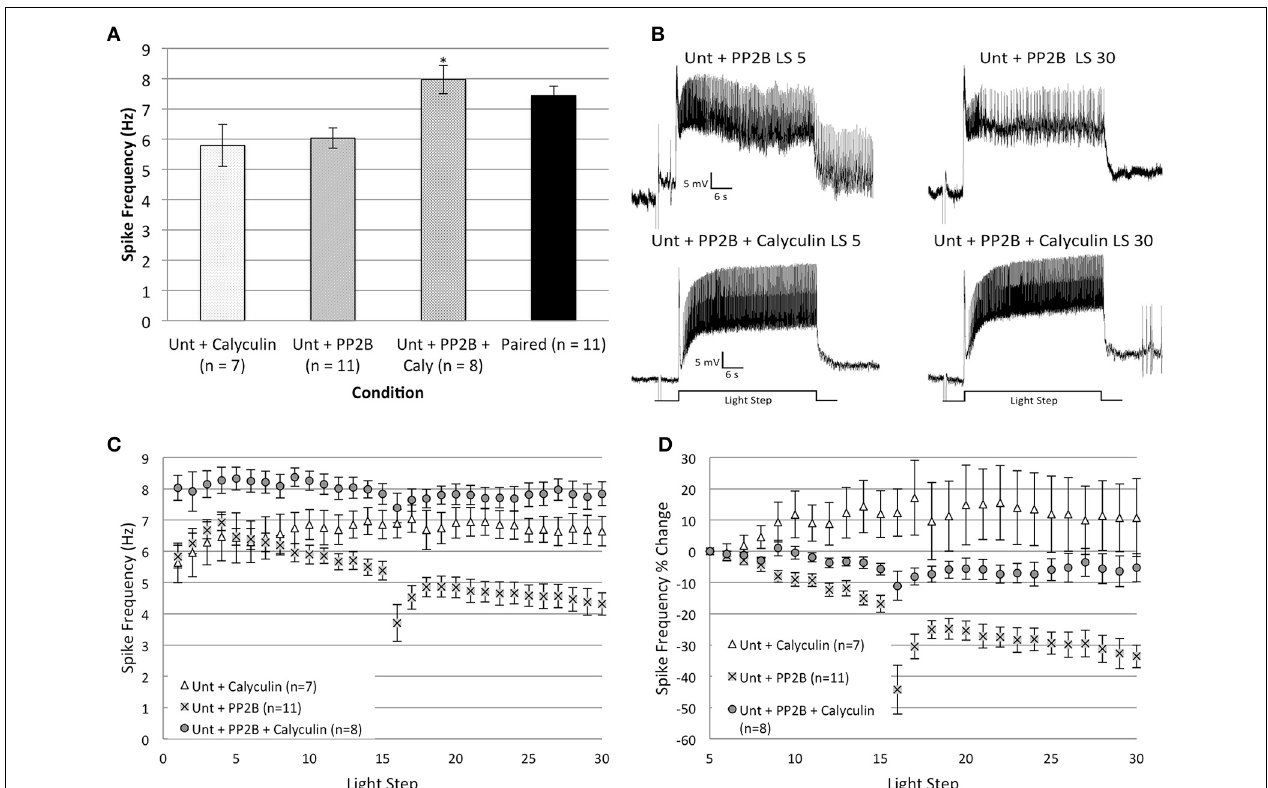
FIGURE 8 | The incubation of Untrained Type B cells in calyculin A (20nM final bath concentration) for 15min prevented the reduction in spike frequency produced by injection of catalytically active PP2B (caPP2B) and increased spiking during the first two LSs. (A) Summary data for average light-evoked spike frequencies during the first two LSs. The combination of caPP2B and calyculin in Untrained cells produced higher spike frequencies compared to cells exposed to either caPP2B or calyculin alone. (B) Representative light responses recorded from an Untrained B cell injected with caPP2B ( Unt + PP2B group; top trace) and an Untrained cell injected with caPP2B in the presence of calyculin ( Unt + PP2B + Calyculin ; bottom trace). The Unt + PP2B cell showed a large reduction in spike frequencies over the course of 30 LSs. Calyculin blocked this caPP2B-produced reduction in spike frequency.